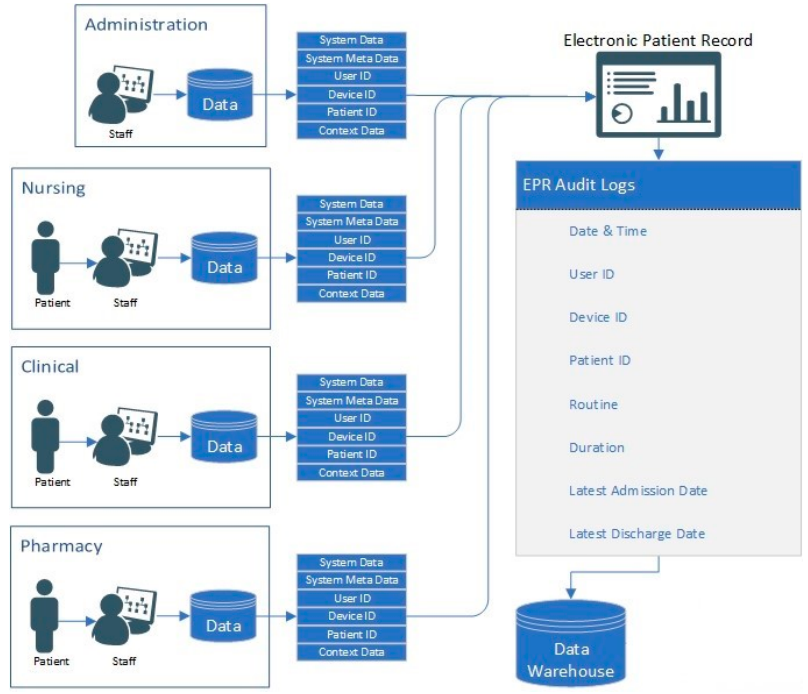
Figure 1. Electronic patient record (EPR) data.